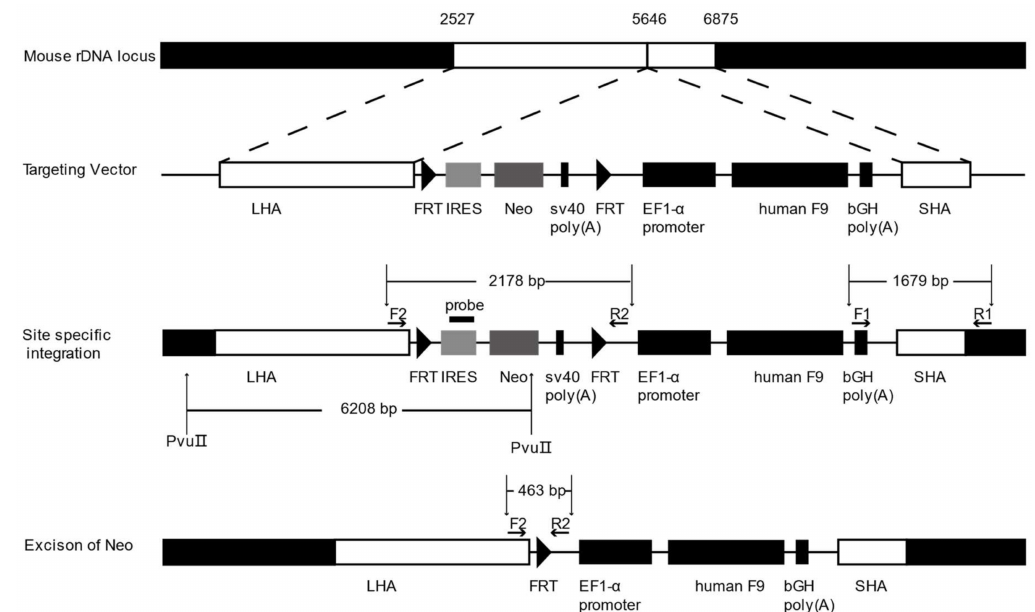
Figure 2. The structure of the non-viral vector pMrnF9 and the schematic diagram of gene targeting into the mouse rDNA locus. LHA, long homologous arm, is homologous to the 2527–5646 region of mouse 45S pre-ribosomal DNA sequence. SHA, short homologous arm, is homologous to the 5646–6875 region. Two short flippase recognition target (FRT) sites flank the Neo expression cassette, which links to the internal ribosome entry site (IRES) of encephalomyocarditis virus. By promoter trapping, Neo can be transcribed via the in situ rDNA promoter after homologous recombination. A universal promoter EF1- α is utilized to drive the human F9 expression cassette. Positive targeted cells with site-specific integration of exogenous genes can be filtered by PCR using primer F1 and R1 with a product of 1679 bp. When the genome DNA of targeted clones is digested by PvuIIand detected with the probe homologous to the IRES element, the site-specific clones will show a band of 6208 bp. The Neo cassette can be excised by expression of Flpe recombinase. The excised clones can be filtrated by PCR with the primer F2 and R2. A 463 bp band will appear from excised clones while a 2178 bp band remains in original